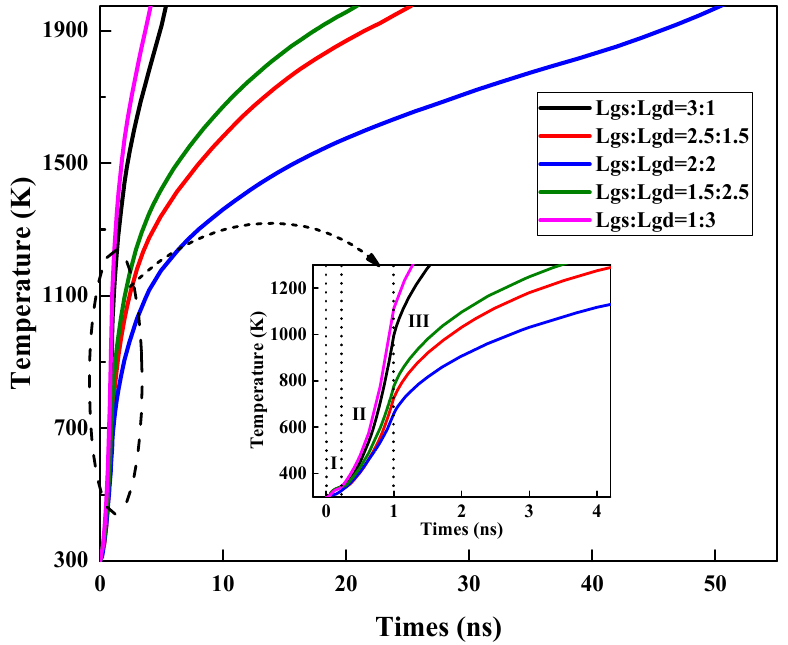
Figure 7. Variation in the maximum temperature (Tmax) inside the GaN HEMT with injection time for different device structures.